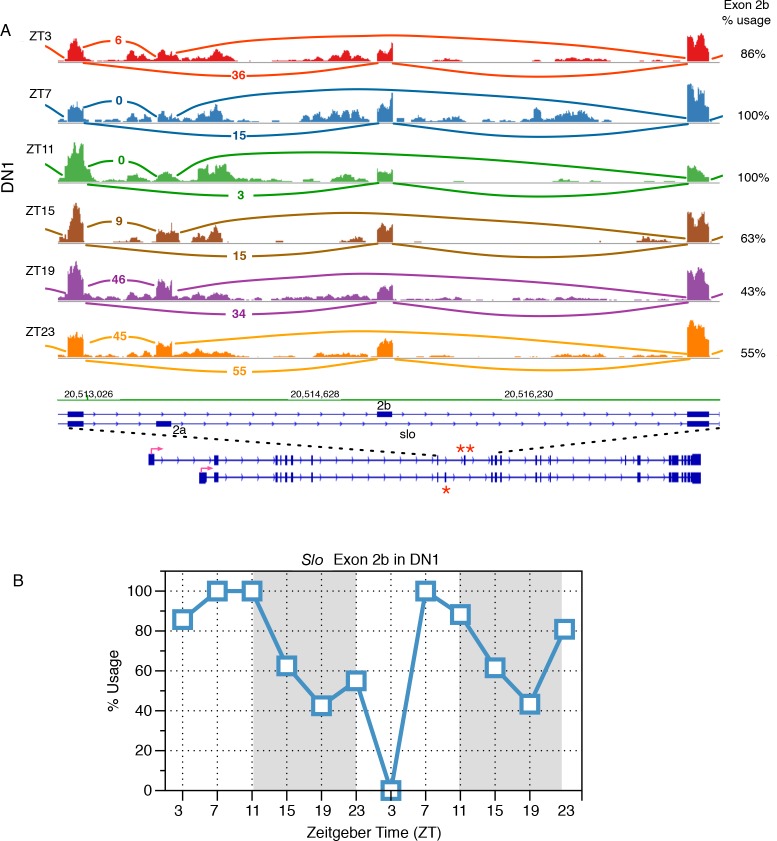
Identification of slo transcripts that exhibit cycling alternative splicing in Drosophila circadian neurons.(A) Slowpoke (Slo) undergoes cycling alternative splicing in DN1 neurons. Sashimi plots highlight RNA-seq signals within the region of Slo that where exons 2a (marked by ‘*’) and exon 2b (marked by ‘**’) are mutually exclusively included. The architecture of the Slo gene is shown below; the red arrow indicates the direction of transcription. Time of day is indicated by Zeitgeber time (ZT) on the left side of the figure; ZT0 is the beginning of 12 hr of lights-on and ZT12 is the beginning of 12 hr of lights-off. In the morning, exon 2b of the Slo transcript is preferentially used then during the night there is a shift to the inclusion of exon 2a instead. (B) The slowpoke (slo) channel shows time-of-day dependent variation in the usage of exon 2a and 2b in DN1 neurons. Exon 2b is primarily included in the morning and then its usage drops in the night as splicing switches to include exon 2a instead.